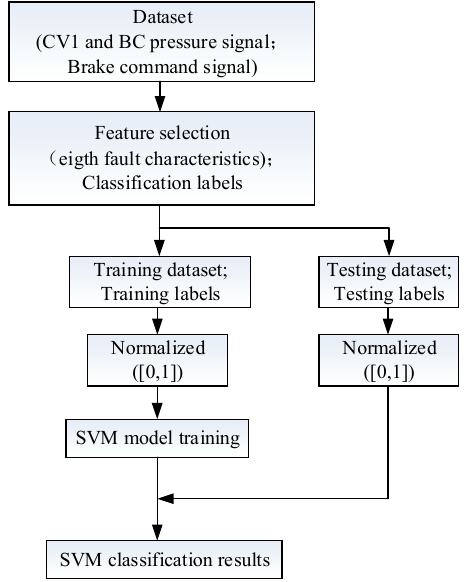
Figure 4. Leakage diagnosis process based on support vector machine (SVM) Method.